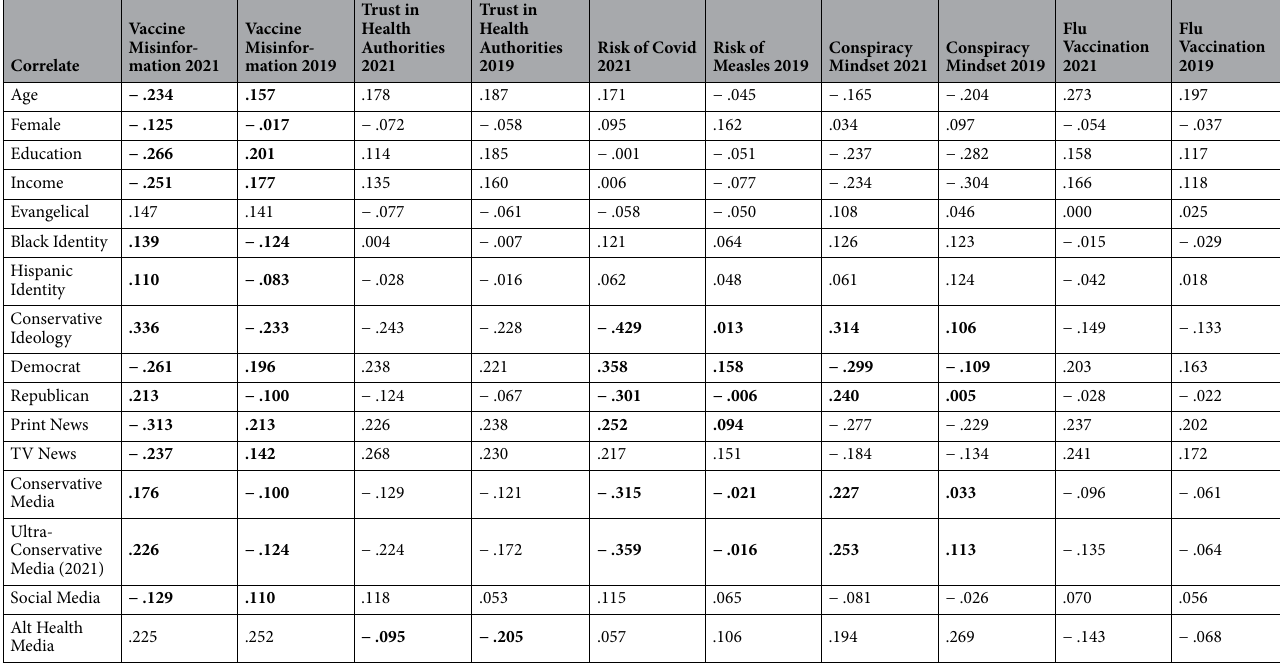
Table 8. Comparisons between correlations with predictors of COVID vaccination in 2019 and 2021 and demographic, political identity, and media use characteristics in 2018/19. Differences greater than 3 standard errors are